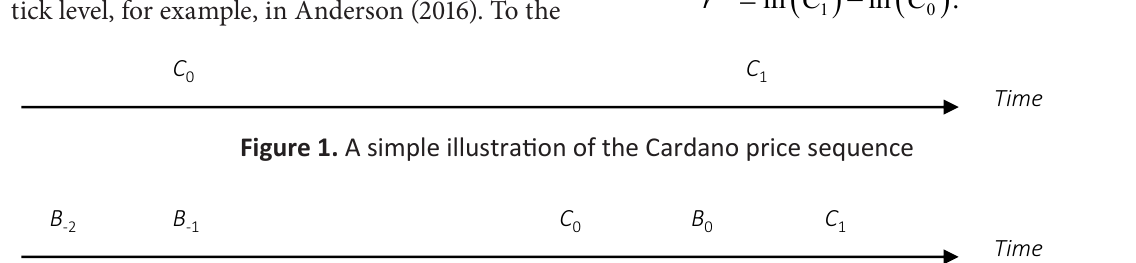
Figure 1. A simple illustration of the Cardano price sequence